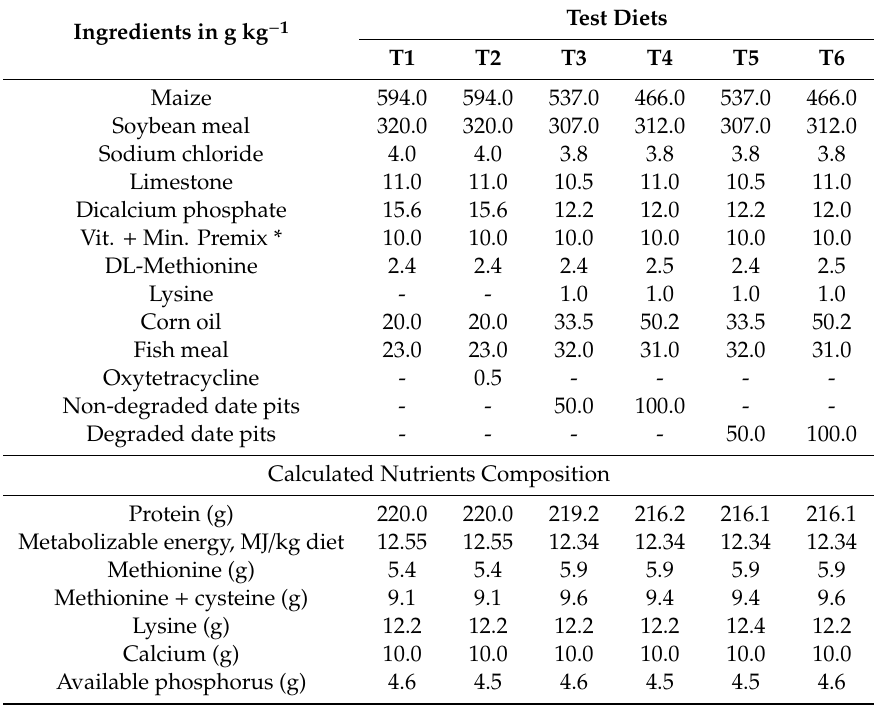
Table 1. The composition of the six experimental starter test diets and their calculated nutrients composition (starter period from day 1 to day